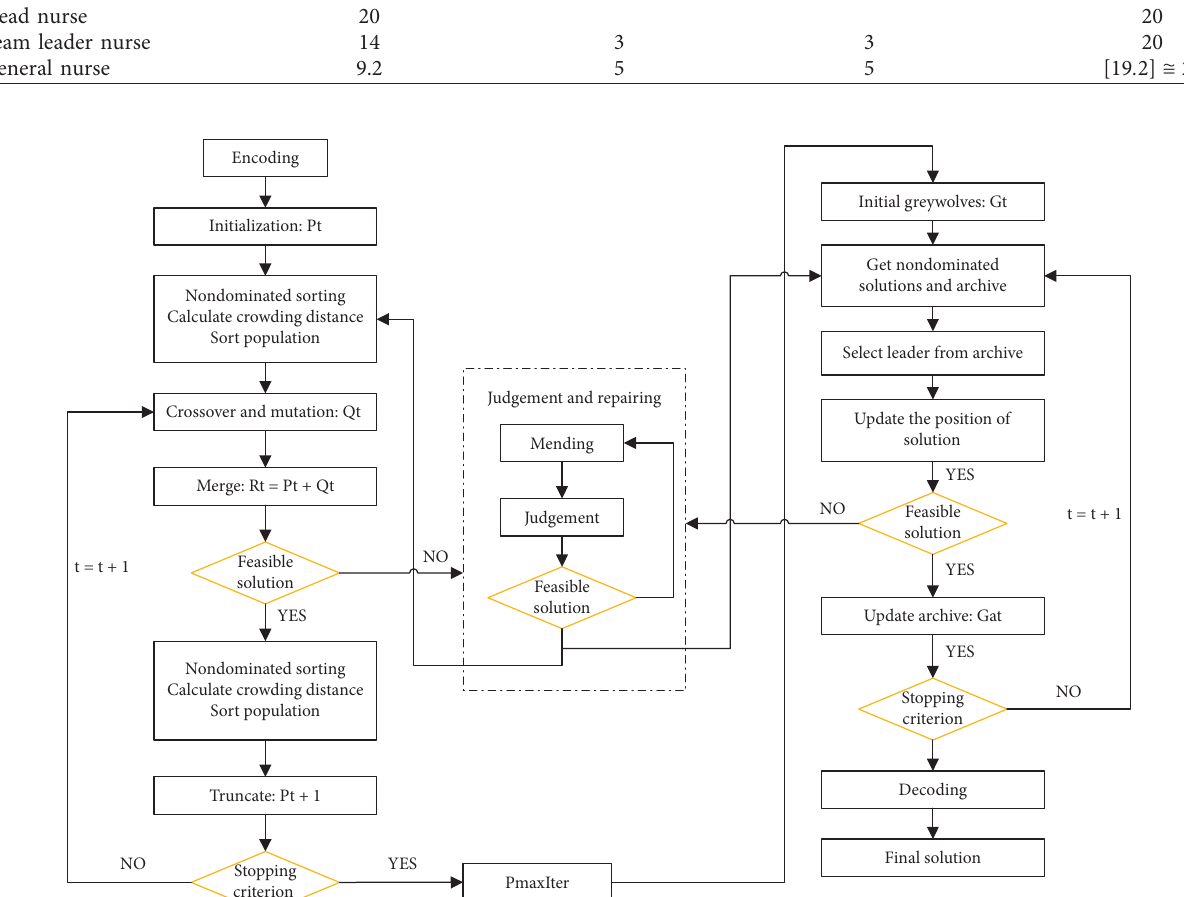
Figure 1: Flowchart of the proposed NSGAII-MOGWO algorithm.